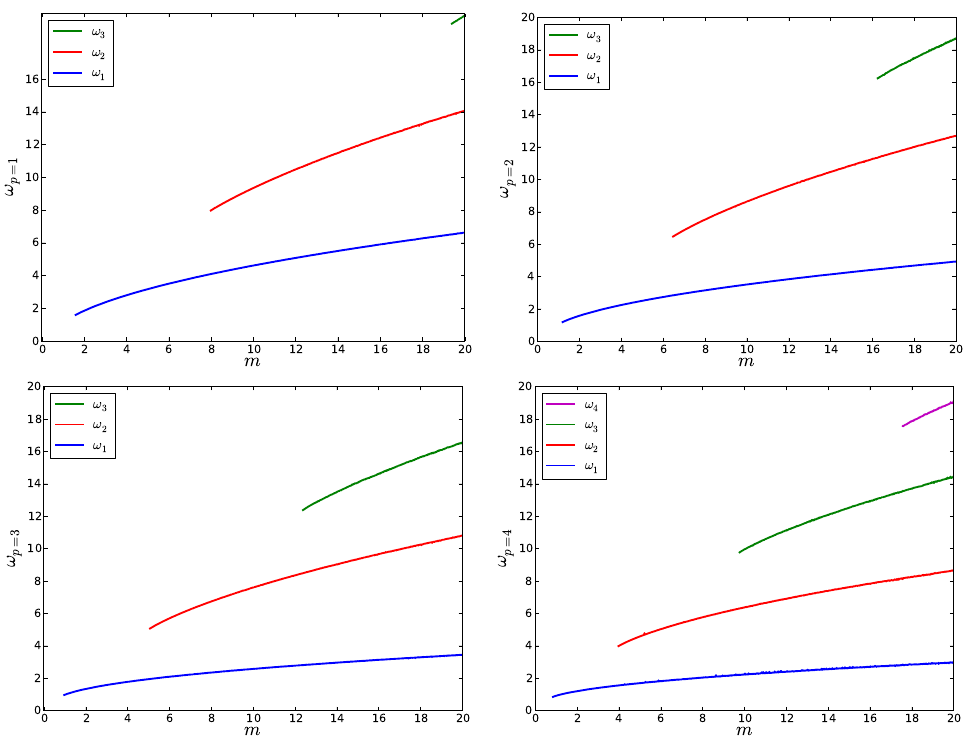
Figure 4 . The frequencies of the (cid:12)rst oscillating modes for L 024 Skyrme model as a function on the pion mass m for the Lin-Piette potentials, for p = 1 ; 2 ; 3 ;